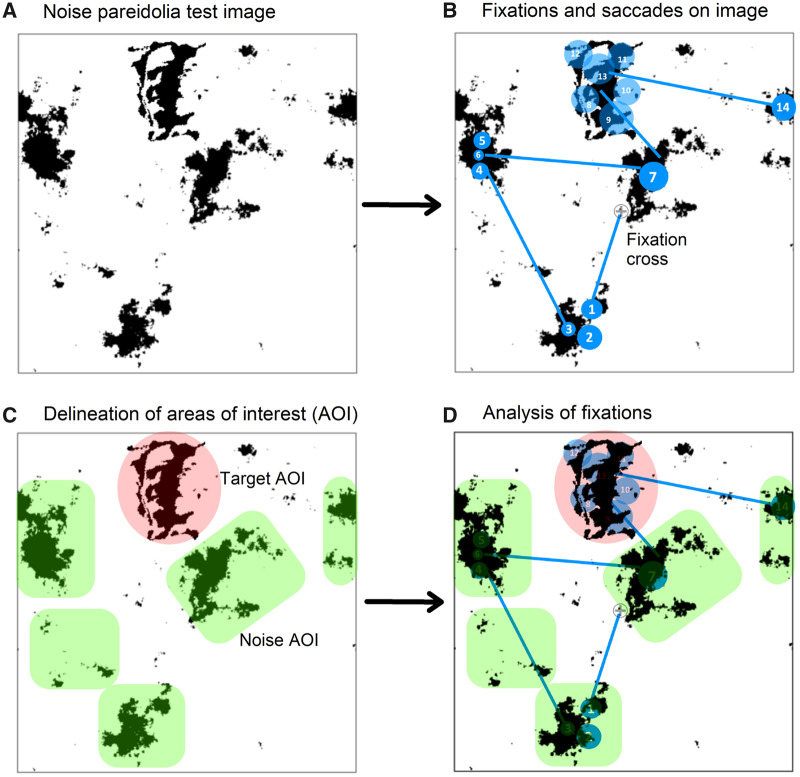

Overview of methodology for eye-tracking in a NPT image. (A) Example of a stimulus image with Mooney face embedded in the NPT. (B) Graphical representation of fixations (blue numbered bubbles) and saccades (blue solid lines) during visual scrutiny. The size of the bubble is proportional to the duration of fixation. Grey fixation cross shown is only for demonstration. (C) Prior demarcation of AOI on the stimulus presentation software—red ellipse for target faces and green polygons for noise. Most, if not all, target faces on the NPT were in the periphery removing the possibility of a central fixation bias (Tatler et al., 2005). (D) Post-processing and analysis of fixation data were done with respect to mean values obtained from each AOI.